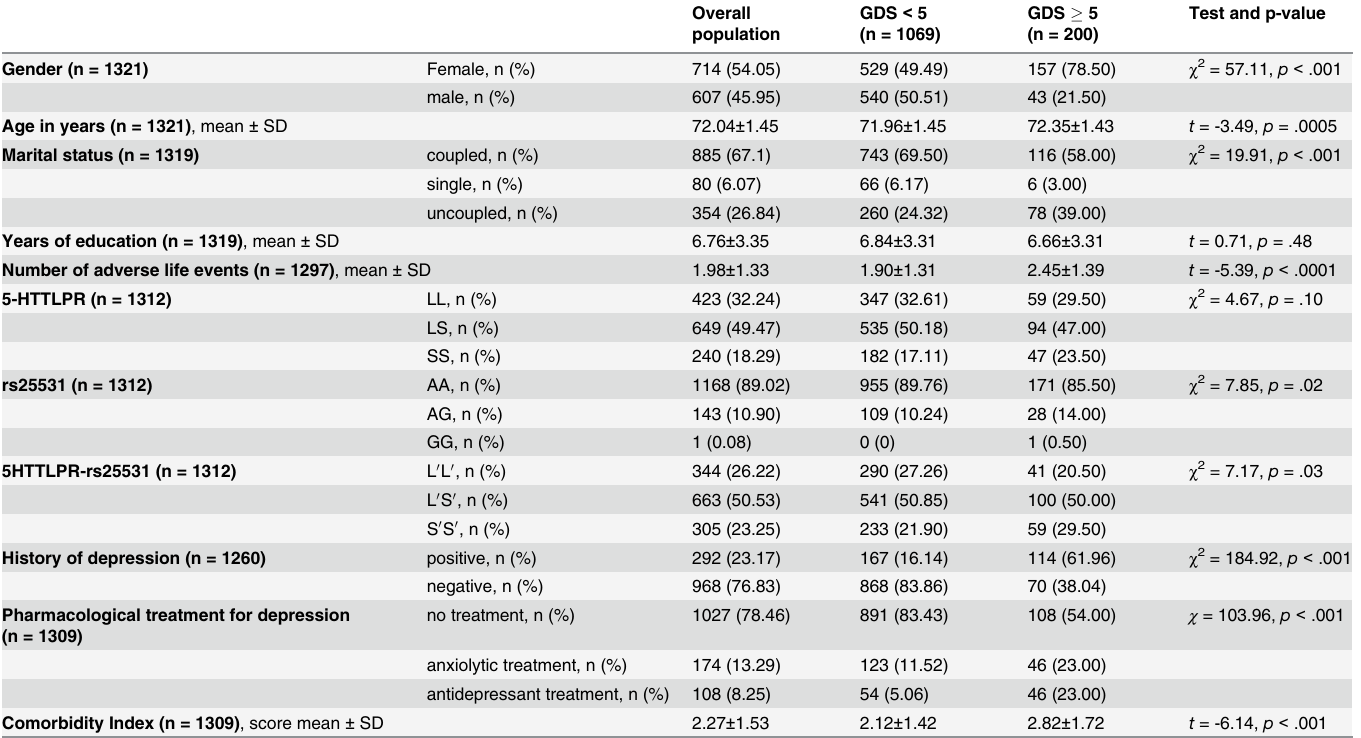
Table 1. Overview of the baseline characteristics of the cohort. The summary statistics (mean and standard deviation) or the frequency distribution of each variable are shown in the overall population and by the presence/absence of clinically relevant depressive symptoms (GDS (cid:1) 5 vs GDS < 5).The statisti- cal tests and p-values relative to analyses by GDS categories are also